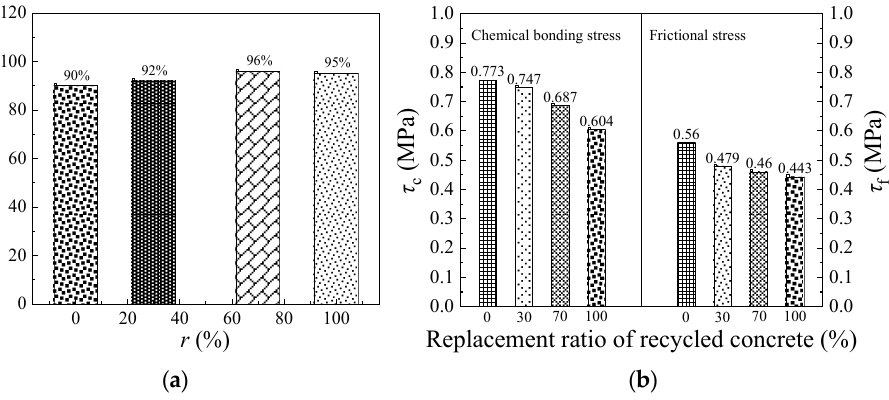
Figure 13. The effect of replacement ratio of recycled concrete on the bonding capacity, they should be listed as: ( a ) The effect of replacement ratio of recycled concrete on l c / l a ; ( b ) effect on the chemical bonding stress and friction resistance stress.